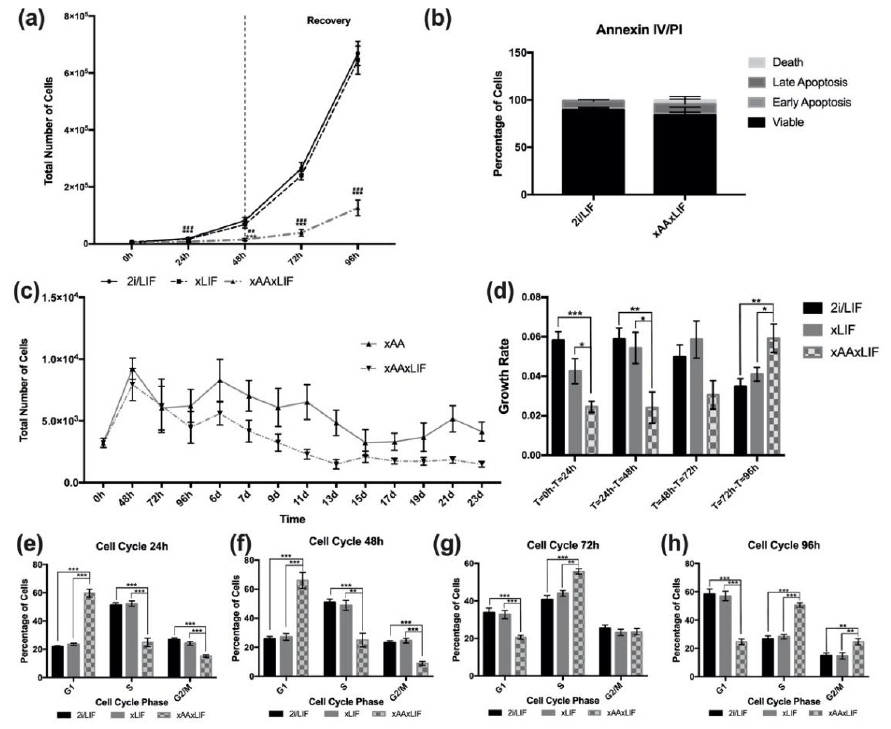
Figure 2. Effects of LIF and Leucine and Arginine withdrawal on mESC proliferation and cell cycle. ( a ) Proliferation of naive mESCs cultured in 2i/LIF media, in the absence of LIF (xLIF) and in the absence of LIF, Leu, and Arg (xAAxLIF). Cells were counted every 24 h until the 96 h time point. At the 48 h time point, the regular culture conditions were reestablished for xLIF and xAAxLIF conditions for the recovery period. Results are presented as mean ± SEM, (2i/LIF: n = 10); (xLIF: n = 8); (xAAxLIF: n = 8), ( b ) After 48 h of culture in 2i/LIF and xAAxLIF conditions, cells were incubated with Annexin V and PI and analyzed by flow cytometry. Results depicting the percentage of cells gated for each quad are presented as mean ± SEM ( n = 4/group). ( c ) Growth curve of mESCs cultured in 2i/LIF media in the absence of Leu and Arg (xAA) (Figure 1c), in the absence of LIF, Leu, and Arg